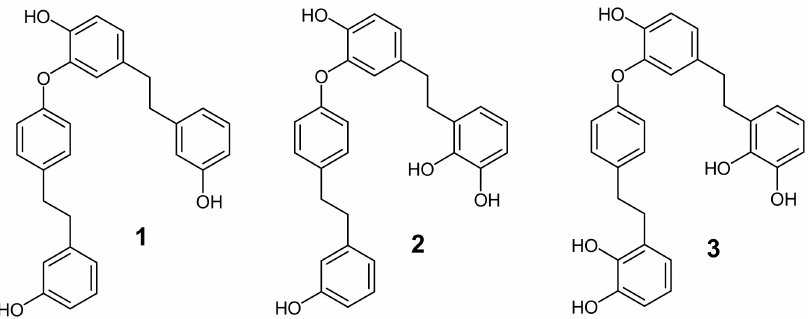
Figure 1. Perrottetin-type bis-bibenzyls isolated from P. endiviifolia . For the analysis of the biological activity, additional perrottetin-type compounds (4–7) and bibenzyl lunularin (8) isolated in previous works [17,19] were added to the isolated compounds 1, 2, and 3: perrottetin F (4), 8-hydroxyperrottetin F (5), perrottetin F-6 (cid:48) -sulphate (6), 2,3,7-trihydroxy-4-(3 (cid:48) -hydroxy-1-bibenzyloxy)-phenanthrene (7), and lunularin (8) (Figure